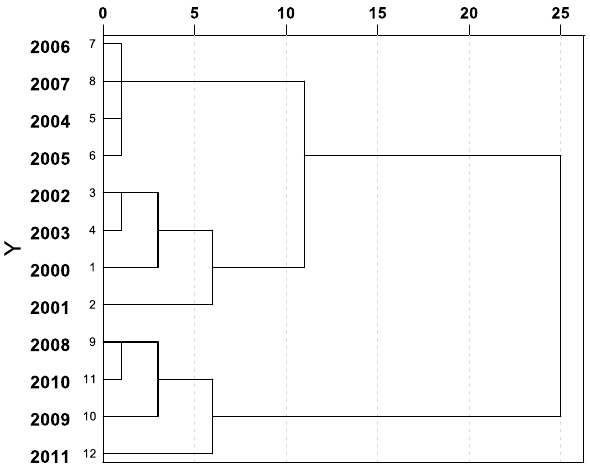
Fig. 1 Dendrogram of interannual clustering results (D